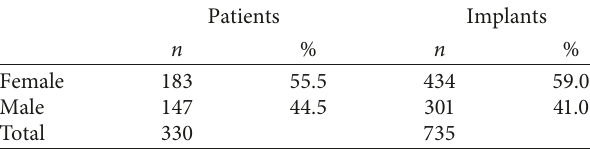
Table 1: Number of patients and implants according to gender.